Question: What caption would you write for this figure?
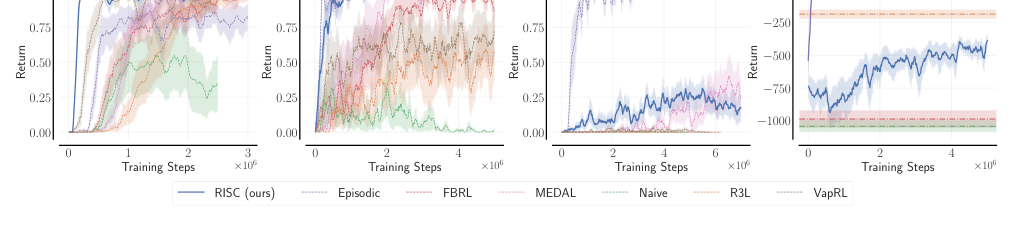
Answer: Average test returns on EARL benchmark tasks over timestep. RISC improves upon or matches the state-of-the-art for reset-free algorithms on 3 of the 4 environments (Tabletop Manipula- tion, Sawyer Door, Sawyer Peg), and even outperforms/matches the Episodic baseline on Sawyer Door and Sawyer Peg. Learning curves and code were not available for several baselines for Minitaur, so only the final performance is plotted. Results are averaged over 5 seeds and the shaded regions represent standard error.